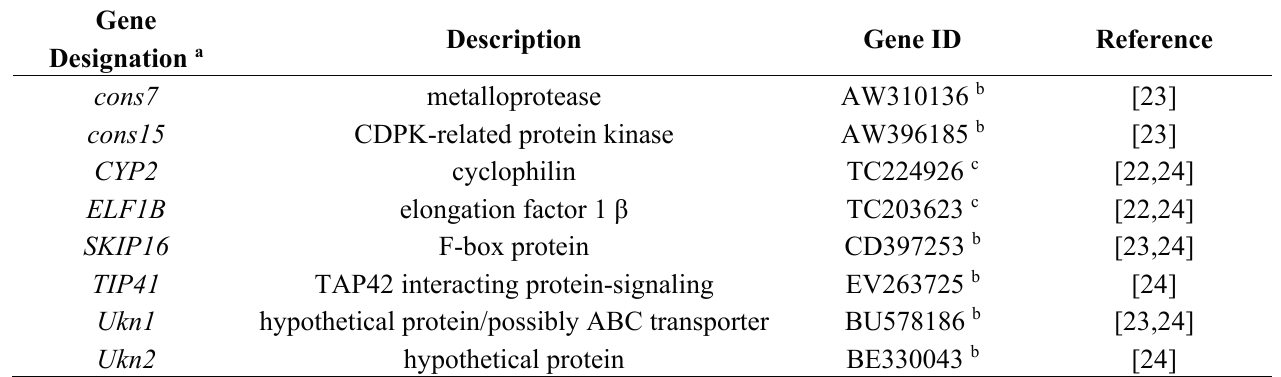
Table 2. Candidate reference genes for G. max